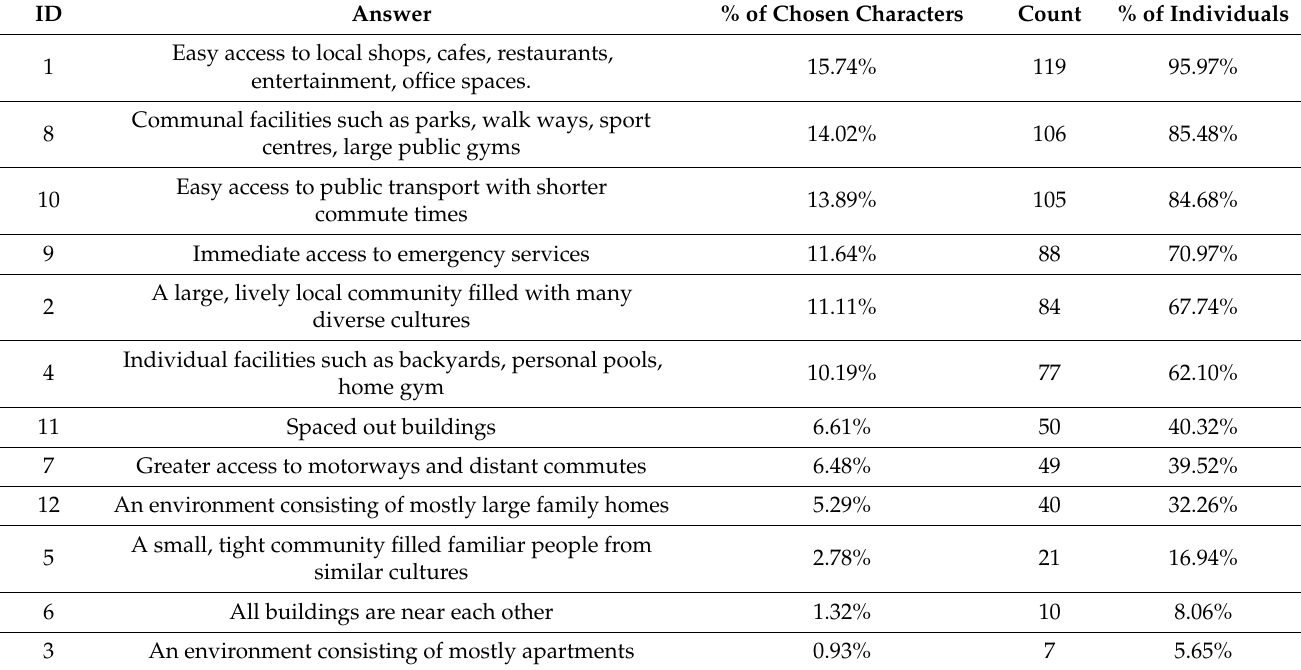
Table 6. Highest local characteristics that participants would like to include in their ideal suburb in